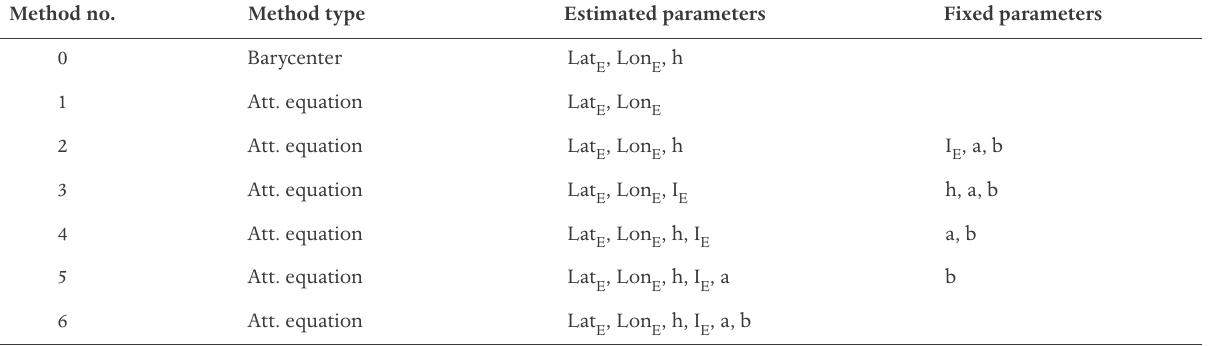
Table 1. Methods to locate the hypocenter of the version 4.0 of Boxer code [Gasperini et al. 2010] and estimated parameters. The methods maximize a log-likelihood function for a dataset of intensity observations with respect to the six unknown parameters. I h: hypocentral depth (for the method 0 the depth is computed by Musson [1996]); “a”, and “b”, respectively: linear and logarithmic coeffi- cients of the extended attenuation equation [Pasolini et al. 2008]. See formulae 13 and 14 of Gasperini et al. [2010] for more